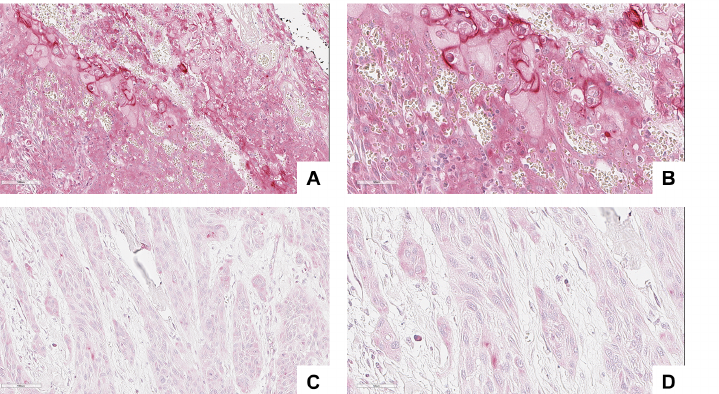
Figure 6. IHC evaluation of Neuropilin-1 tissue expression. ( A , B ): A representative case of Neuropilin-1 high expression. ( C , D ): A representative case of Neuropilin-1 low expression. (Virtual slide magnifications: ( A , C 20×; B , D 40×; scale bars are shown).